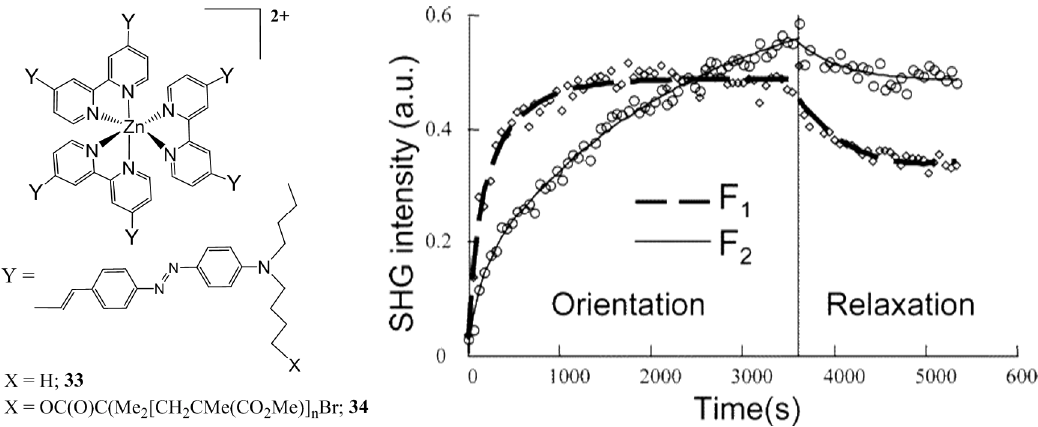
Figure 10. Optical orientation and relaxation of films F1 and F2 under resonant one ‐ photon and two ‐ photon excitations (open circles and diamonds) compared to a biexponential plot (lines). F1 = doped film of 33 ; F2 = grafted polymer film of 34 . Adapted with permission from Ref. [75]. Copyright (2004) American Chemical Society .